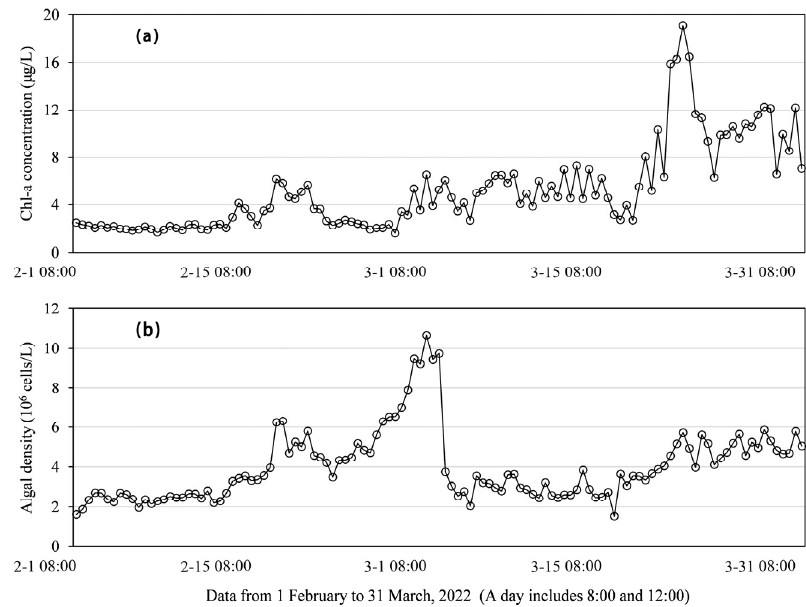
Figure 13. Daily values of ( a ) Chl-a concentration and ( b ) algal density.